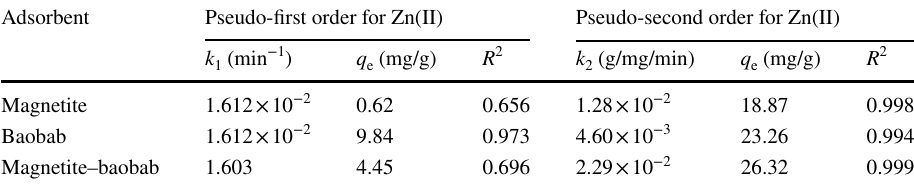
Adsorbent Pseudo-first order for Zn(II)